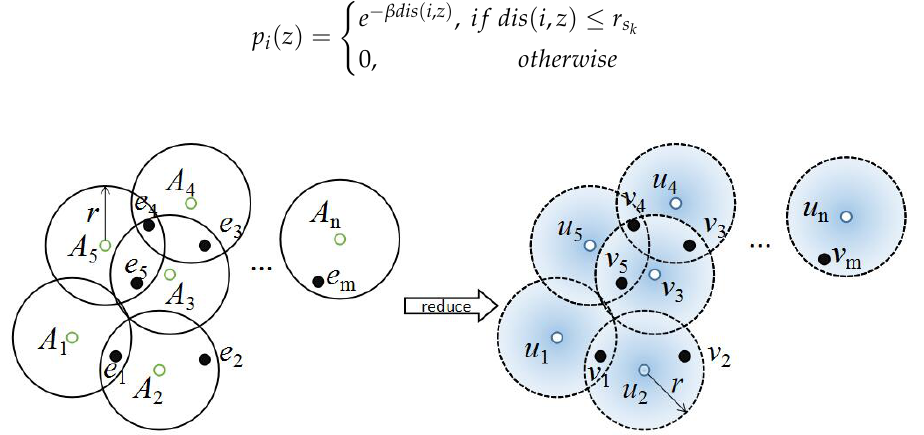
Figure 4. A reduction from the unit disk cover problem to the minimum (cid:101) -detection coverage problem. = r and (cid:101) = e − β r sk We set r s k